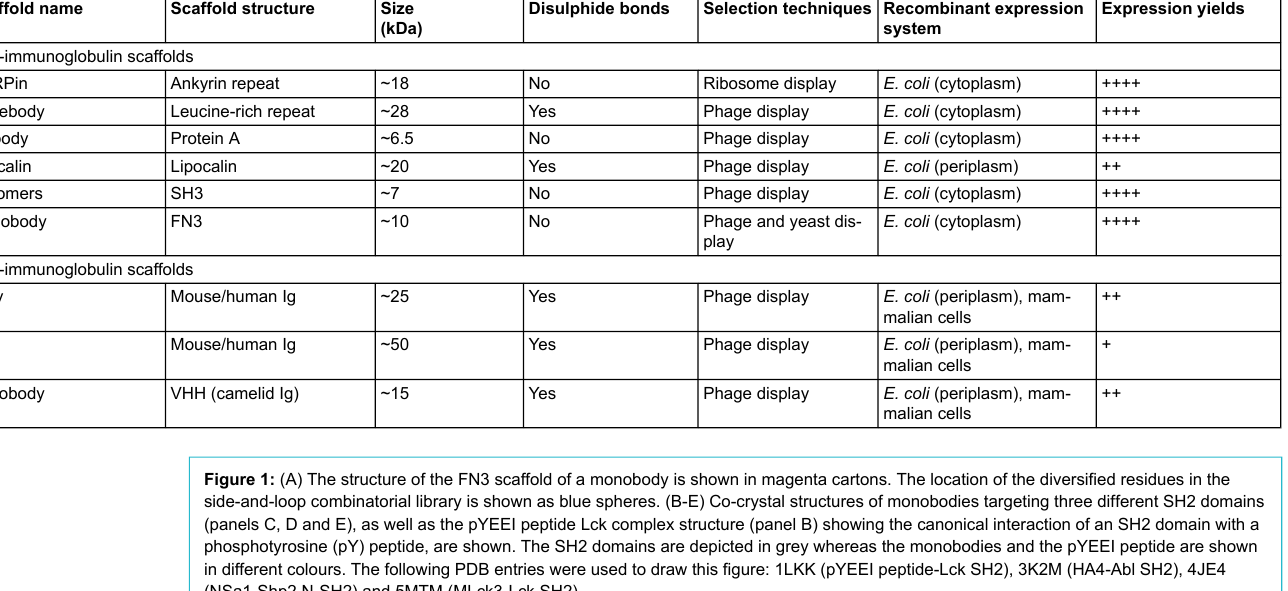
Table 1: Commonly used non- and mini-immunoglobulin scaffolds and their properties. Scaffold name